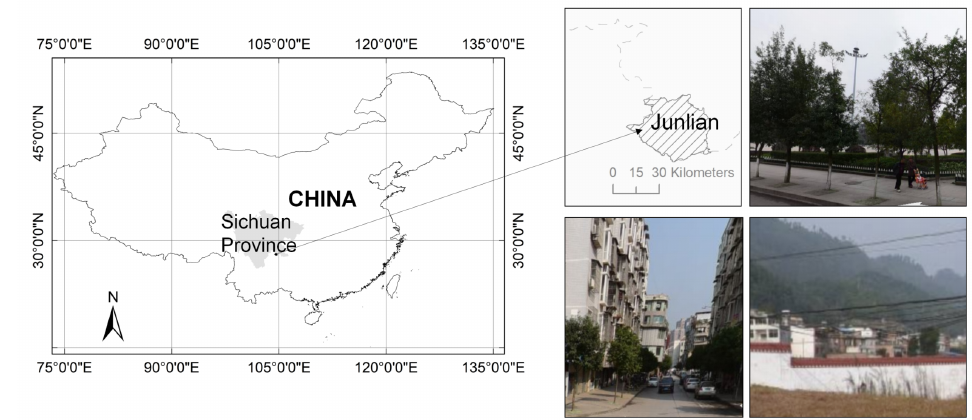
Figure 1. The location and overview of Junlian city, Sichuan Province,